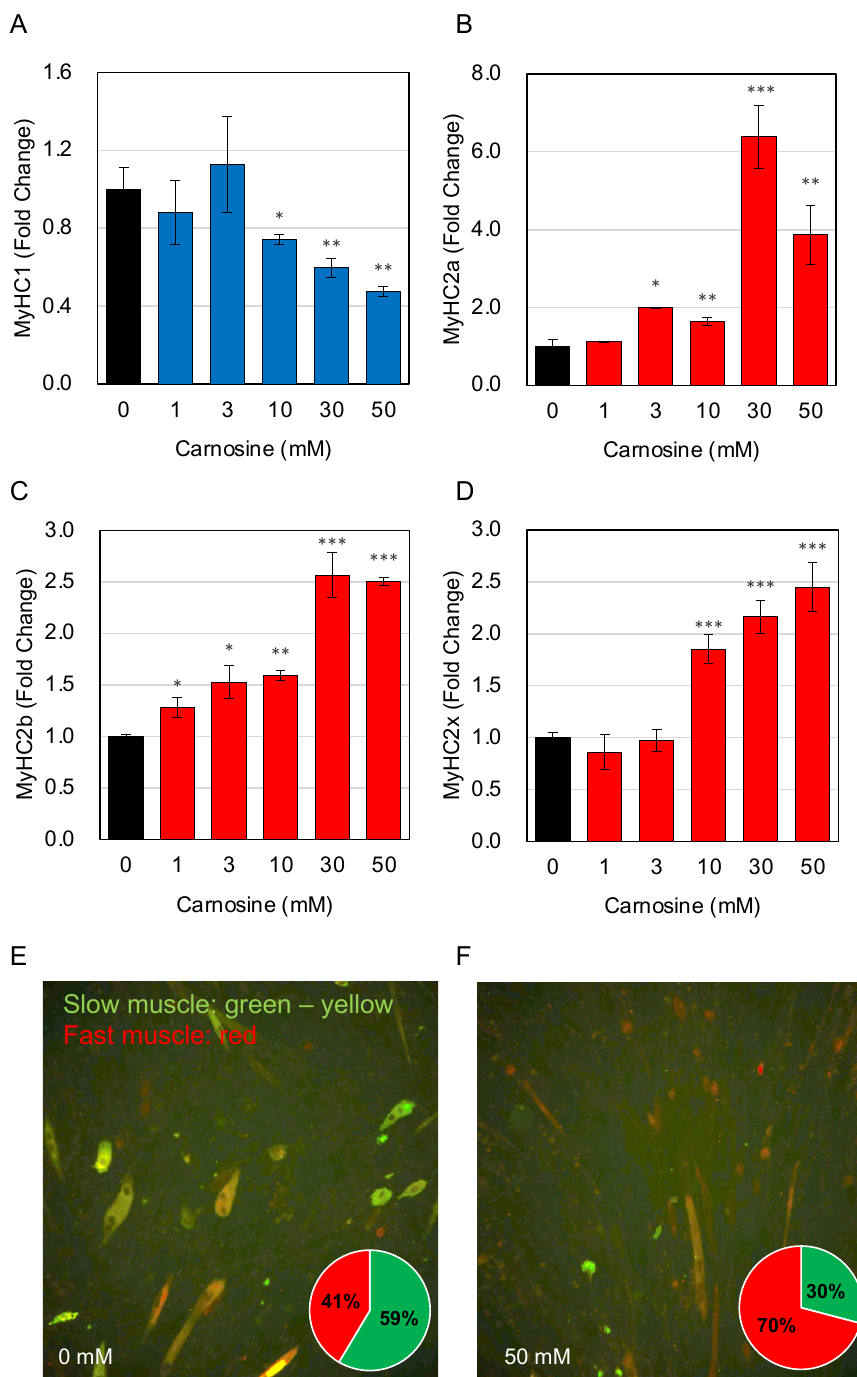
Figure 2. Effects of carnosine on muscle fiber type change. C2C12 cells were differentiated in the presence of indicated amount of carnosine. Expression of slow and fast muscle marker genes of MyHC1 ( A ), MyHC2a ( B ), MyHC2b ( C ), and MyHC2x ( D ) was quantitatively determined by RT- qPCR. Effects of carnosine on muscle fiber type was evaluated by immunocytochemitory using antibodies (rabbit anti-fast myosin skeletal heavy chain (red) and mouse anti-slow skeletal myosin heavy chain (green to yellow)). Relative abundance of fast and slow muscle was determined by using IN Cell Analyzer 2200 (( E ), non-treat; ( F ), 50 mM carnosine treatment). Multiple comparisons between groups were performed using one-way ANOVA with Tukey’s post-hoc test. Statistical significance was defined as p < 0.05 when compared to control (* p < 0.05; ** p < 0.01; *** p < 0.001).